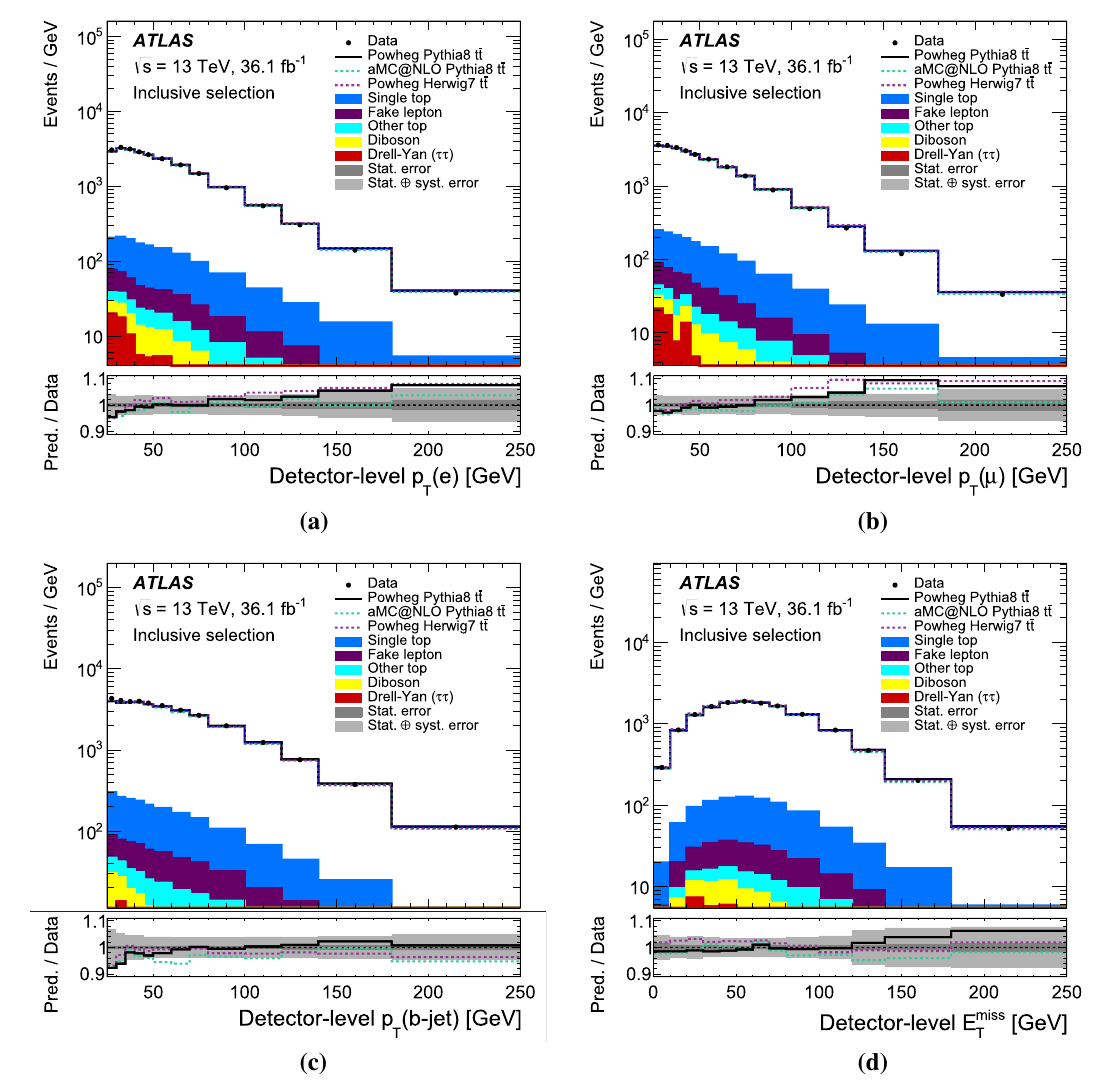
Fig. 1 Kinematic distributions for the a electron p T , b muon p T , c ing transverse momentum, background modelling, pile-up modelling and luminosity, but not PDF or signal t ¯ t modelling uncertainties. The leading b -jet p T , and d E miss for the e ± μ ∓ inclusive selection. In T observed distribution is compared to the sum of signal and background all figures, the rightmost bin also contains events that are above the x -axis range. The dark uncertainty bands in the ratio plots represent using three different t ¯ t signal models: Powheg + Pythia 8, Powheg + Herwig 7 and MadGraph5 _aMC@NLO + Pythia 8, and the ratio the statistical uncertainties while the light uncertainty bands represent panel compares the summed prediction to data for the three models the statistical and systematic uncertainties added in quadrature. The systematic uncertainties include contributions from leptons, jets, miss-